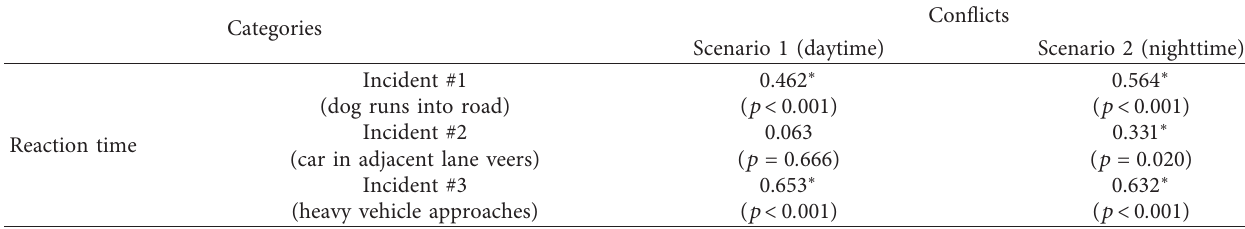
Table 6: Correlation analyses between reaction time and conflicts in three incidents.